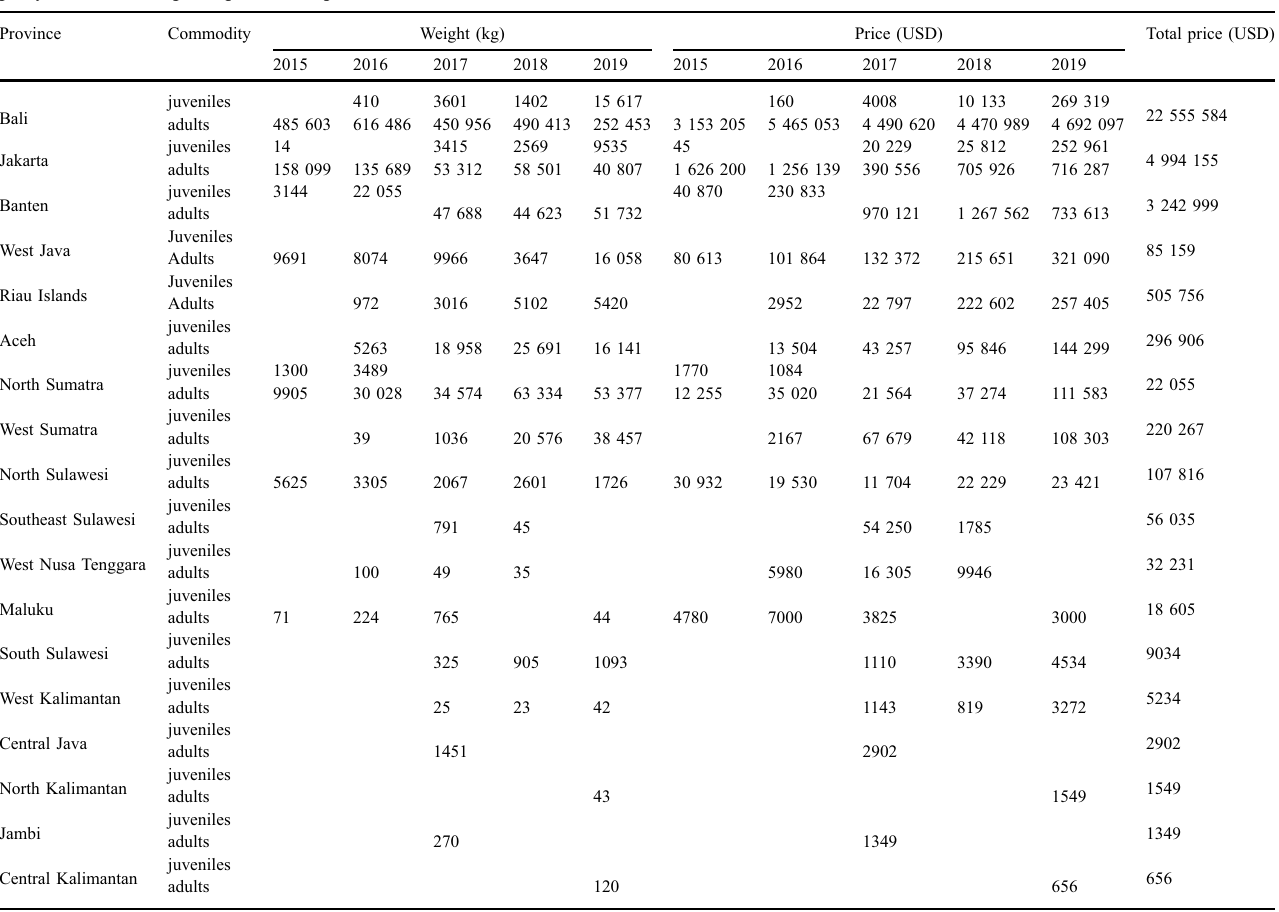
Table 1. Indonesian provinces with recorded exports of marine juvenile and adult fi shes in period 2015 – 2019, their total weight and total price per year, and total price per whole period.